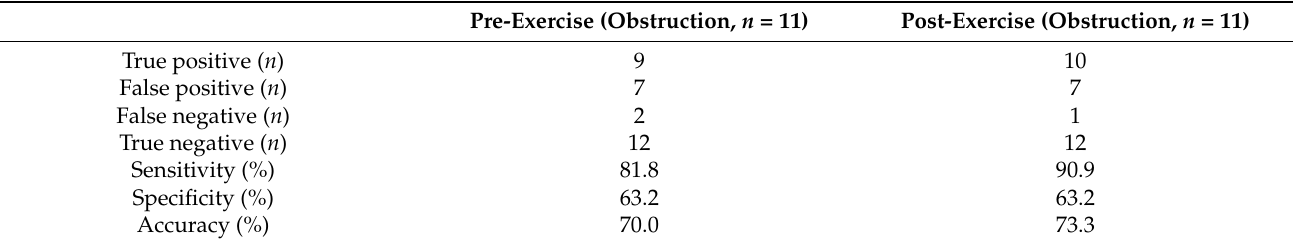
Table 3. The predicted accuracy for obstruction (FEV 1 /FVC < 70%) in the validation set ( n = 30) with the proposed estimated